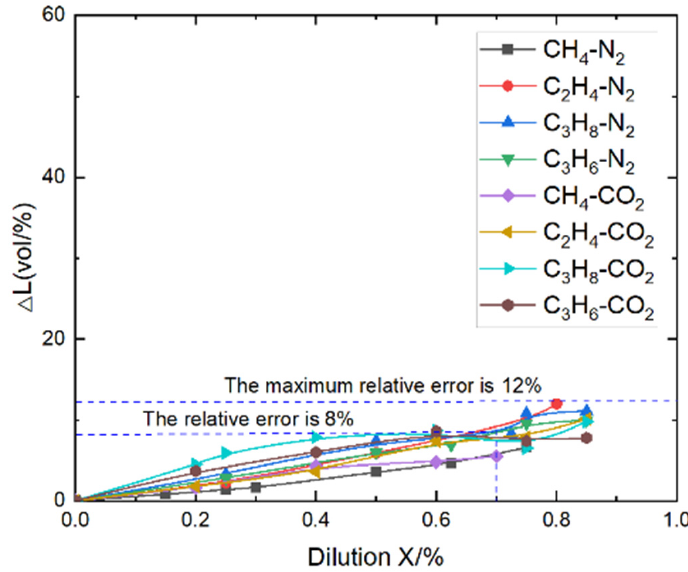
Figure 3. Relative error for lower explosion limit between theoretical predicted value and experimen- tal value.